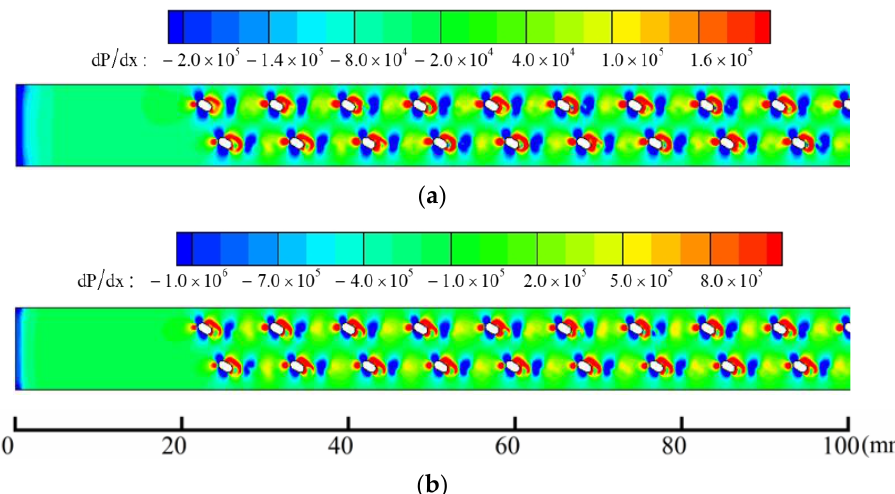
Figure 12. Partial gradient of static pressure in stream-wise component on ( x , z )-planes at y / y 0 = 0.68 for R1 ( a ) and R7 cases ( b ).